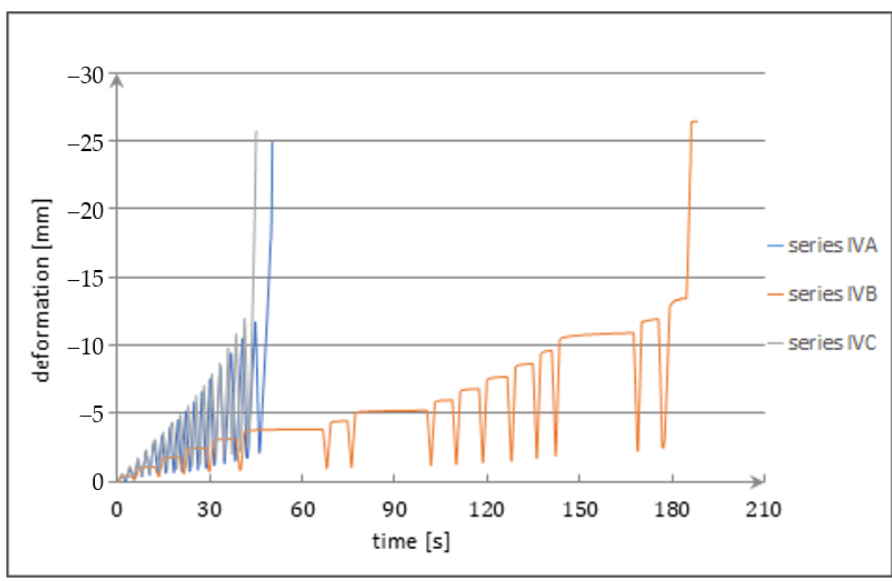
Figure 12. Cycles of strain force in the investigated beam.